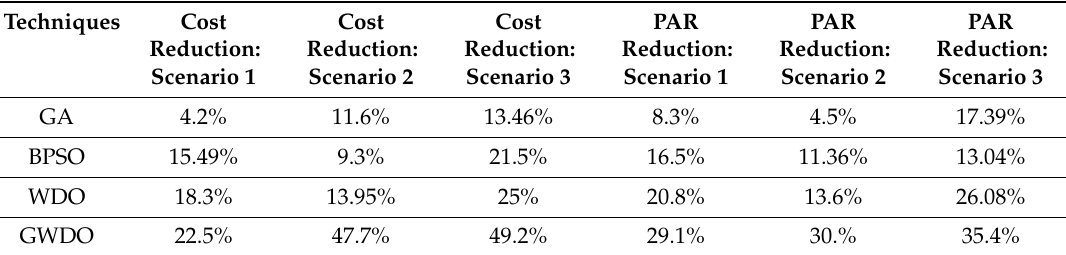
Table 6. Comparative analysis of existing and proposed